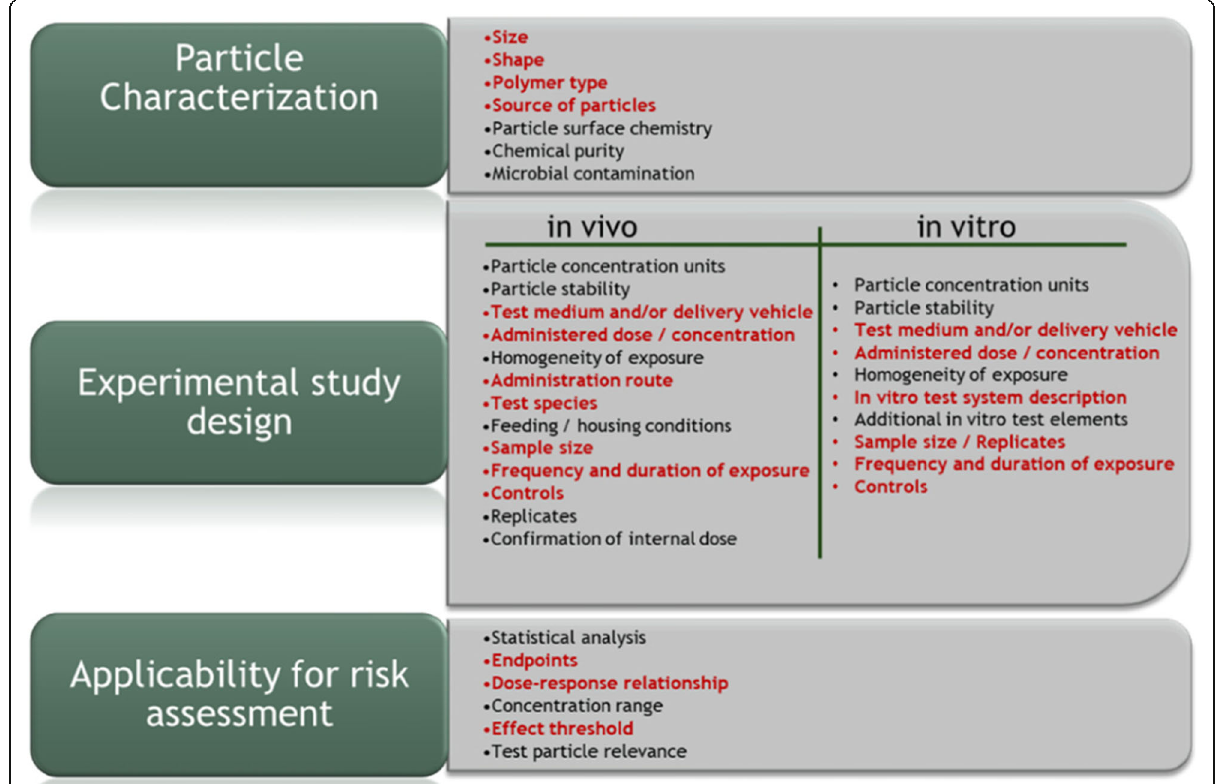
Fig. 1 Schematic summary of the approach used to evaluate in vivo and in vitro effects studies for use in assessing human health risks related to exposure to nano- and microplastic particles. All criteria have equal weight, whereby studies receiving non-zero scores against all criteria would ideally represent studies that should be prioritized for risk assessment. Due to an absence of any study receiving non-zero scores against all criteria, however, the criteria highlighted in red represent the minimal information required for identifying a study as fit-for-purpose in the context of deriving a human health threshold value by participants of the Southern California Coastal Water Research Project (SCCWRP) Health Effects Workshop (https://www.sccwrp.org/about/research-areas/additional-research-areas/trash-pollution/microplastics-health-effects-webinar- series/. The ‘ red ’ criteria can be modified depending on the screening and prioritization purpose and should not be misinterpreted as representing criteria that are critical for determining the reliability and relevance of a study. Tables S1 and S2 provide guidance related to scoring each of the